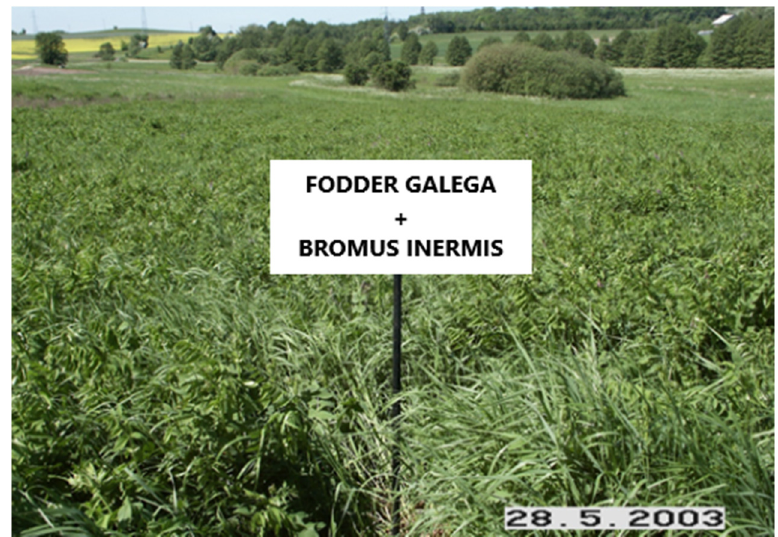
Figure 4. Fodder galega + Bromus inermis in late May ( Ż arczy ń ski 2003).